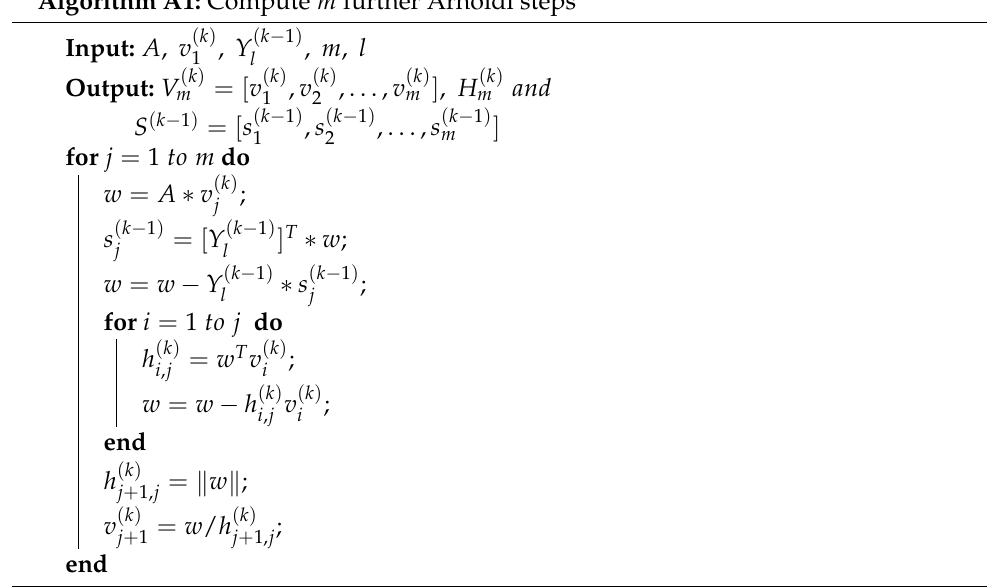
Algorithm A1: Compute m further Arnoldi